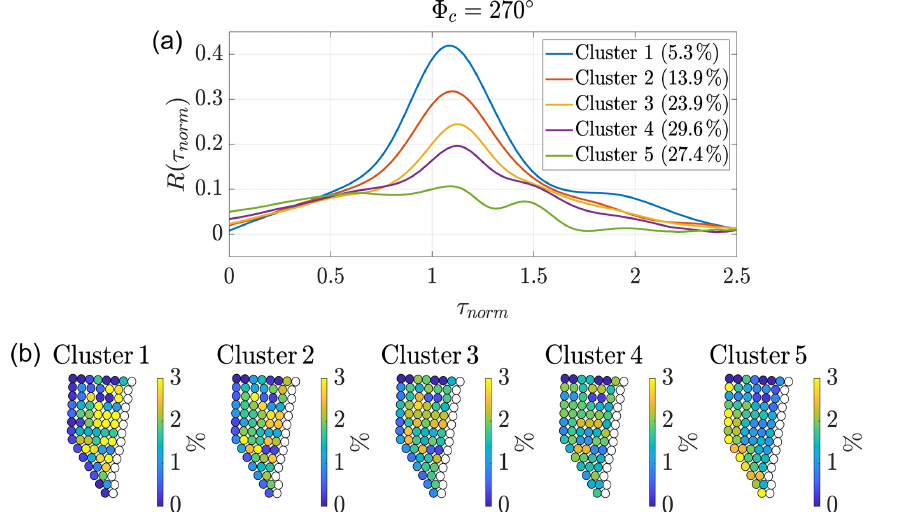
Figure 8. Clustering for wind direction interval around 270 ◦ with randomly sorted 600s time intervals. (cid:56) c depicts the centre of the wind direction interval. Panel (a) shows the average power output fluctuation correlation curve per cluster. The legend lists the share of data. Note that the values do not add up exactly to 100% due to rounding. Panel (b) shows the percentage frequency of each wind turbine pair within the respective cluster given as colour. As the wind turbines are analysed in pairs of two, the last row of wind turbines is unlabelled, as these wind turbines do not have a downstream